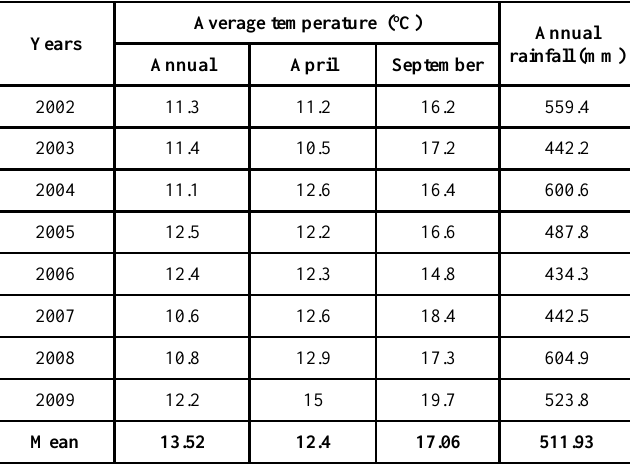
Table 1. Changing of climatic factors during traits